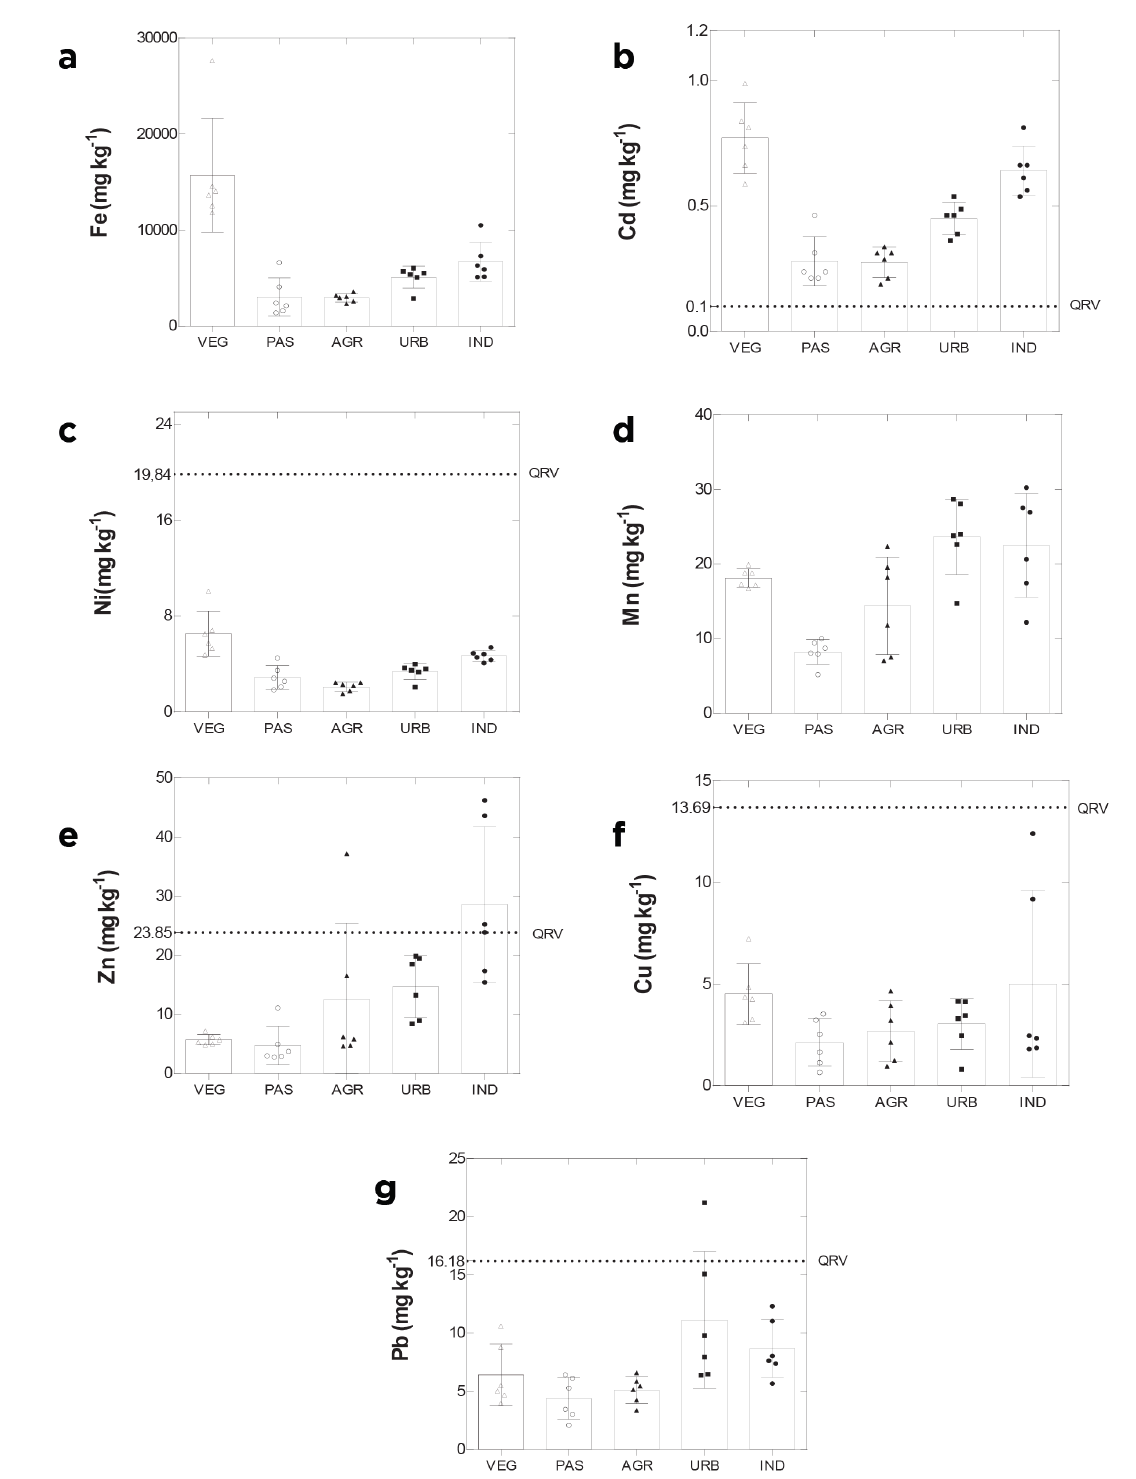
Figure 2. Potentially toxic elements concentrations in land uses around Extremoz Lake, Rio Grande do Norte, Brazil. Natural vegetation (VEG ∆); pasture (PAS Ο); agriculture (AGR ▲ ); urban (URB ■ ); industrial land use (IND ● ). QRV (line) = Quality reference values for heavy metals in soils of Rio Grande do Norte state (Preston et al.